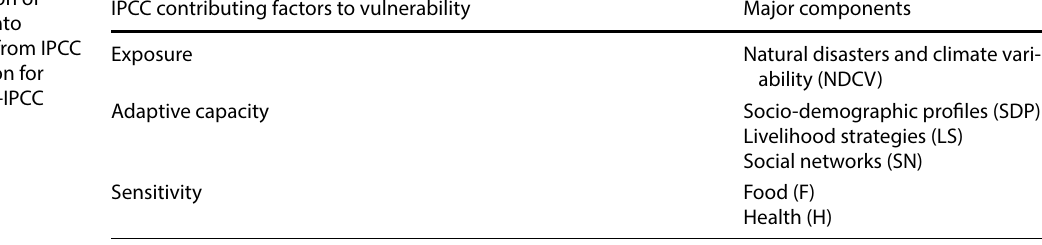
Table 3 Categorization of major components into contributing factors from IPCC vulnerability definition